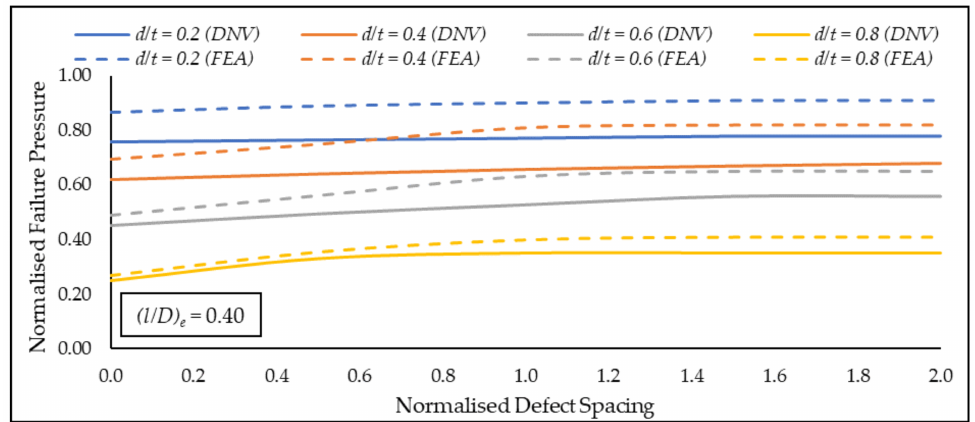
Figure 12. Normalised failure pressure predictions of FEA and DNV for API 5L X80 pipe subjected to internal pressure only for interacting